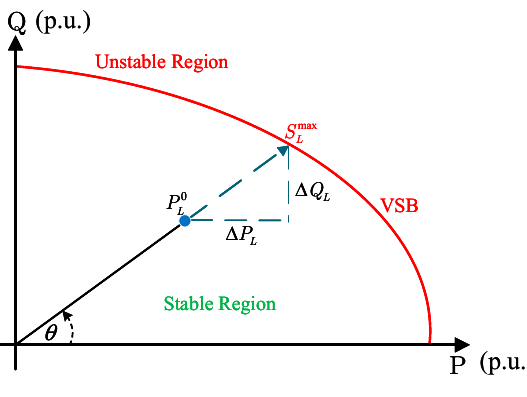
Figure 8. Voltage stability boundary (VSB) in a complex load power space. Algorithm 1 Construction of a VSB curve in P-Q plane